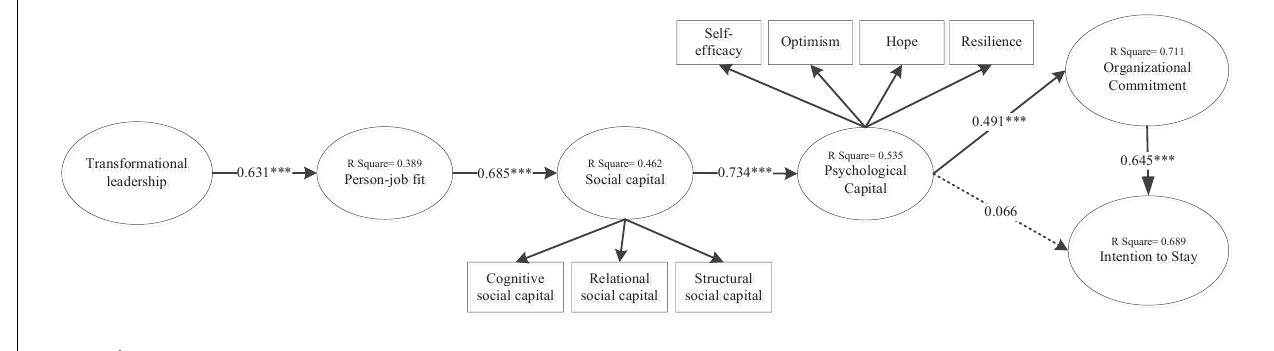
FIGURE 2 | Research results. ∗∗∗ p < 0.001.